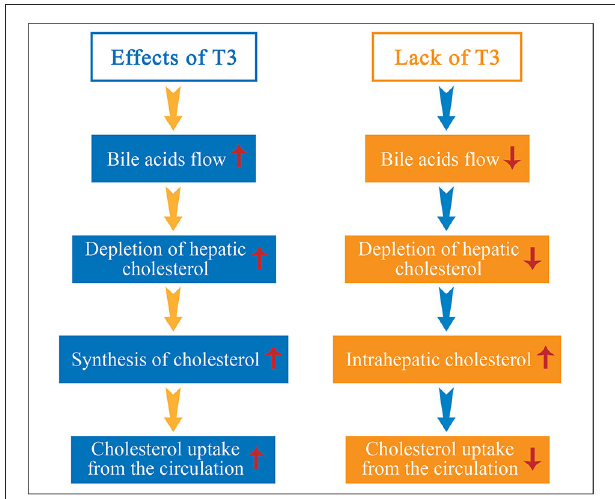
FIGURE 1 | Thyroid hormone (TH) increases the synthesis of cholesterol and bile acids (BA) flow, resulting in depletion of hepatic cholesterol and enhancement of cholesterol uptake from the circulation to the liver. By contrast, in hypothyroidism, diminution of TH results in slowing of BA flow, marked diminution in the rate of cholesterol secretion into the bile, increase of intrahepatic cholesterol despite the decrease in cholesterol biosynthesis, and decrease of hepatic uptake of cholesterol from the